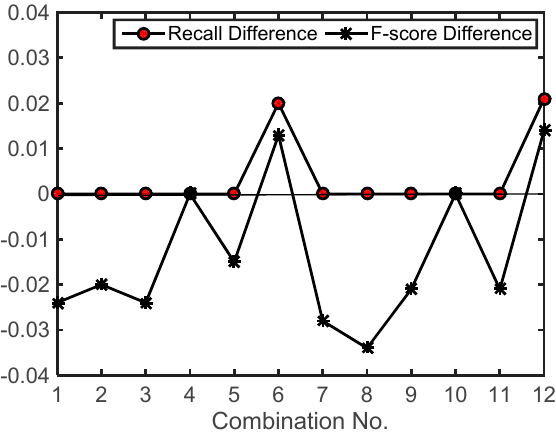
Figure 10. The effects caused by changing significance level on test site 1. Recall (F-score) difference is the product of the recall (F-score) generated by using a significance level of 0.05 minus the one generated by using a significance level of 0.10. The parameter values for each combination can be found in Table 2. MaxD = 1.5 m, and score threshold = 9.